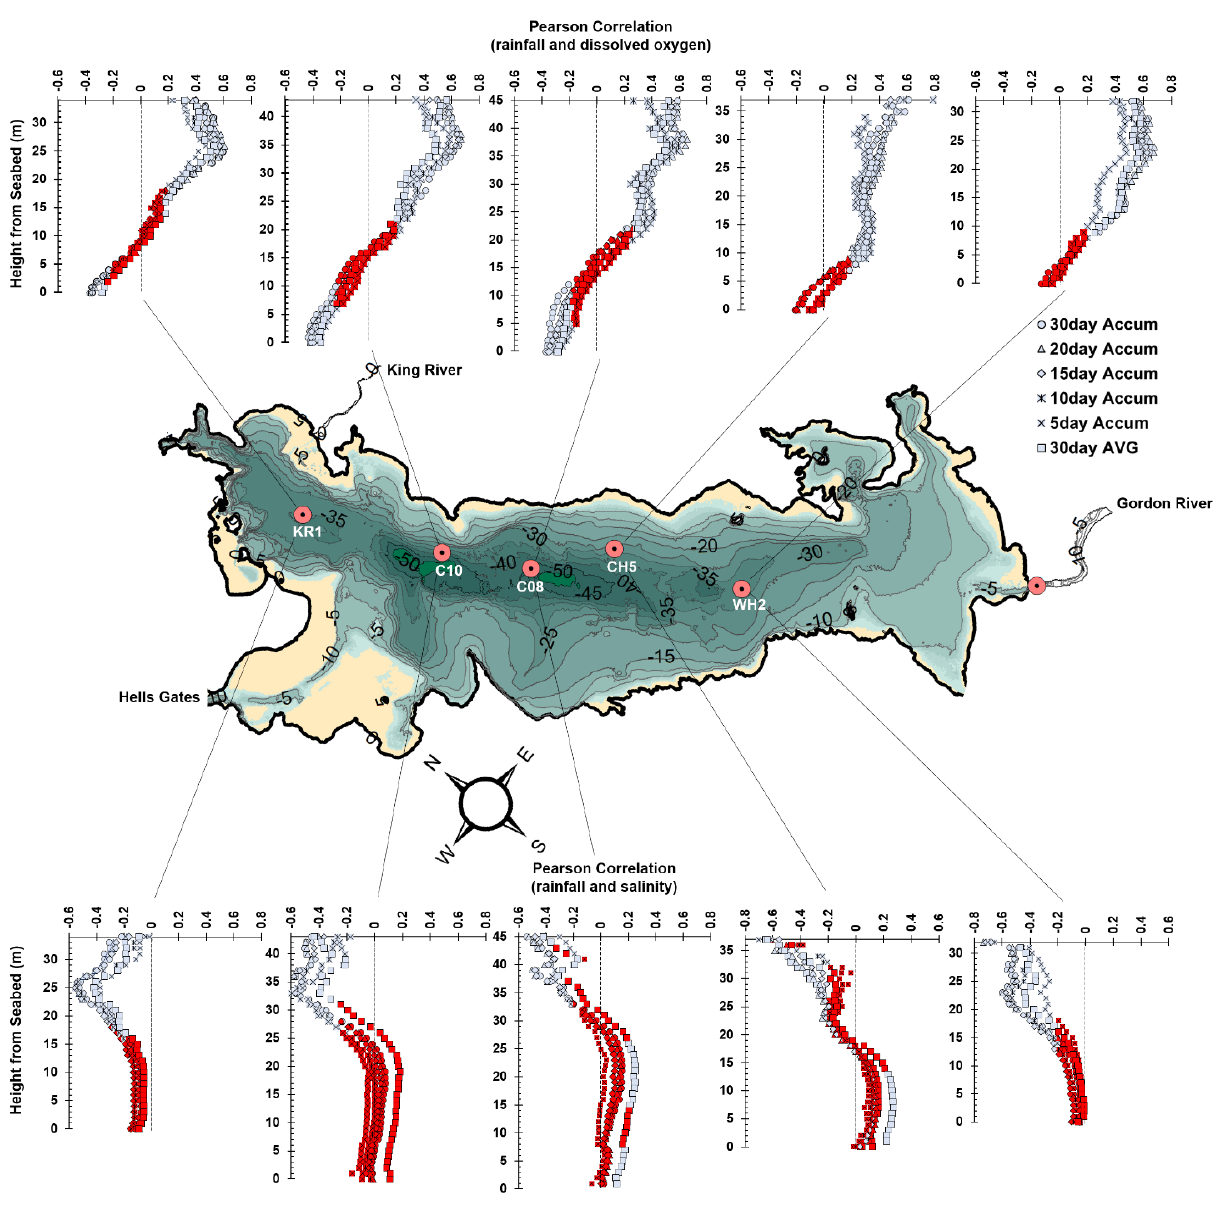
Figure 8. Pearson correlation coefficients ( r ) between rainfall and dissolved oxygen (top) and rainfall and salinity (bottom) through the water column at 1m vertical resolution. Selected rainfall metrics include accumulation 30d prior to sampling (circles), 20d (triangles), 15d (diamonds), 10d (asterisk), and 5d ( x ) accumulation, and 30d average daily rainfall prior to sampling (squares). Red symbols denote statistically insignificant correlations ( p< 0 . 05). Vertical dished lines represent r =